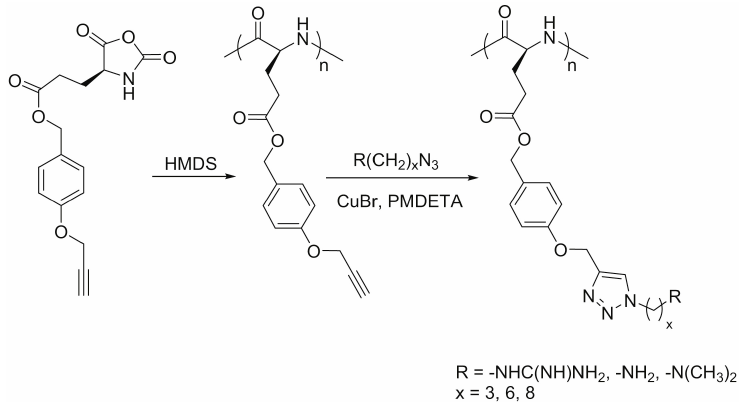
Figure 20. Synthetic route for the preparation of amine/guanidine functionalized polypeptides from poly( γ -(4-propargyloxybenzyl)- L -glutamic acid). Reproduced with permission from reference [89].